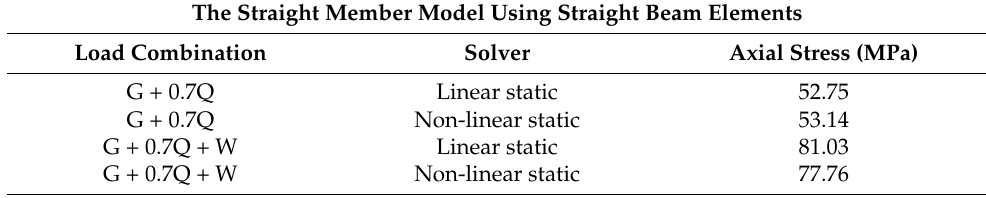
Table 12. Maximum axial stress on each type of structural component (Non-linear static